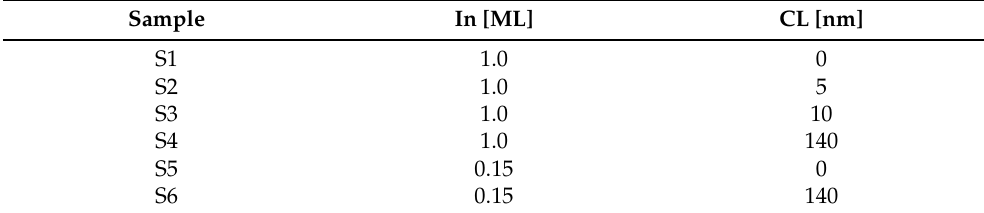
Table 1. Amounts of In and CL thickness relative to all the samples presented in this study (S1–S6).